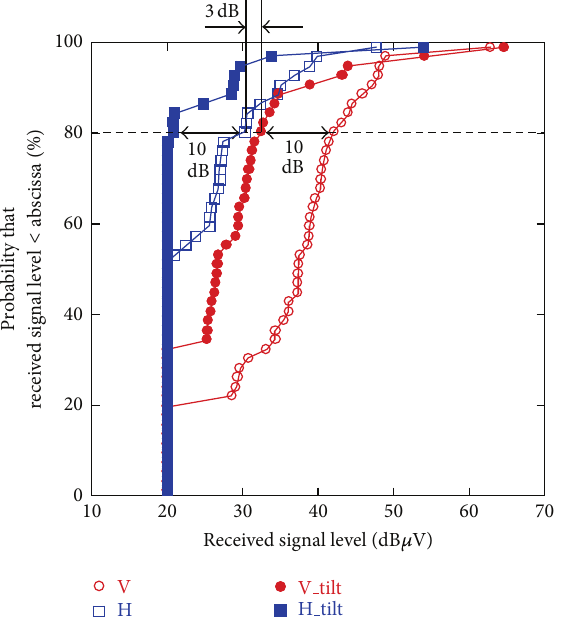
Figure 13: Cumulative distribution of the received CCI level.